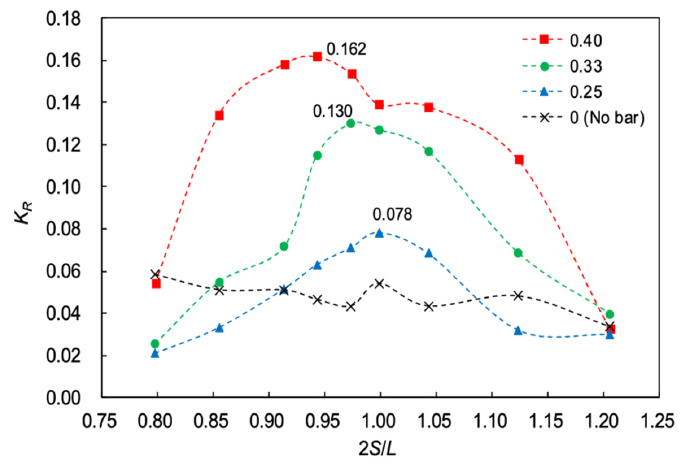
Figure 13. Influence of the relative height D / h on the Bragg resonant reflection, rectangle, N = 4, φ = 68.85%, B = 0.3 m, S = 1.0 m, and H = 0.04 m. According to the numerical calculations and experimental results of Guazzelli et al.